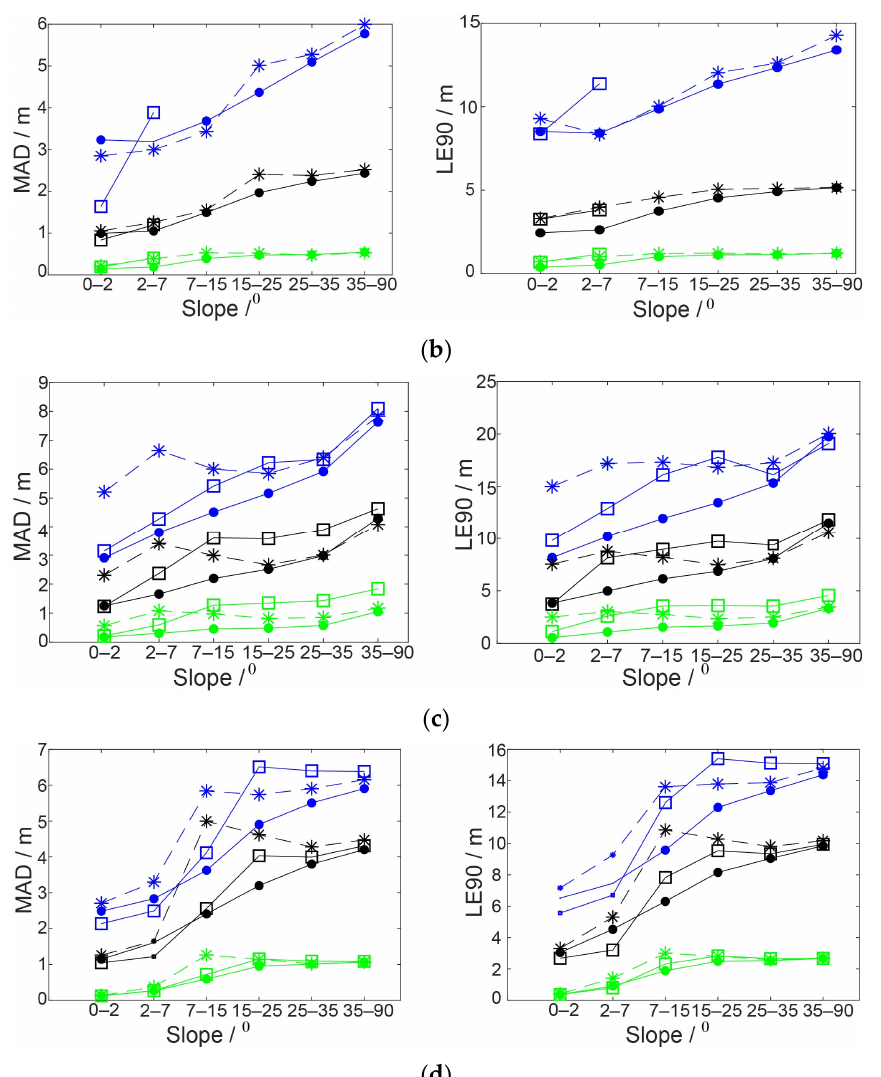
Figure 16. The relationship between quality indicators ((left) MAD and (right) LE90) and land cover in four study areas: ( a ) Sichuan; ( b ) Xinjiang A; ( c ) Xinjiang B; and ( d ) Inner Mongolia.